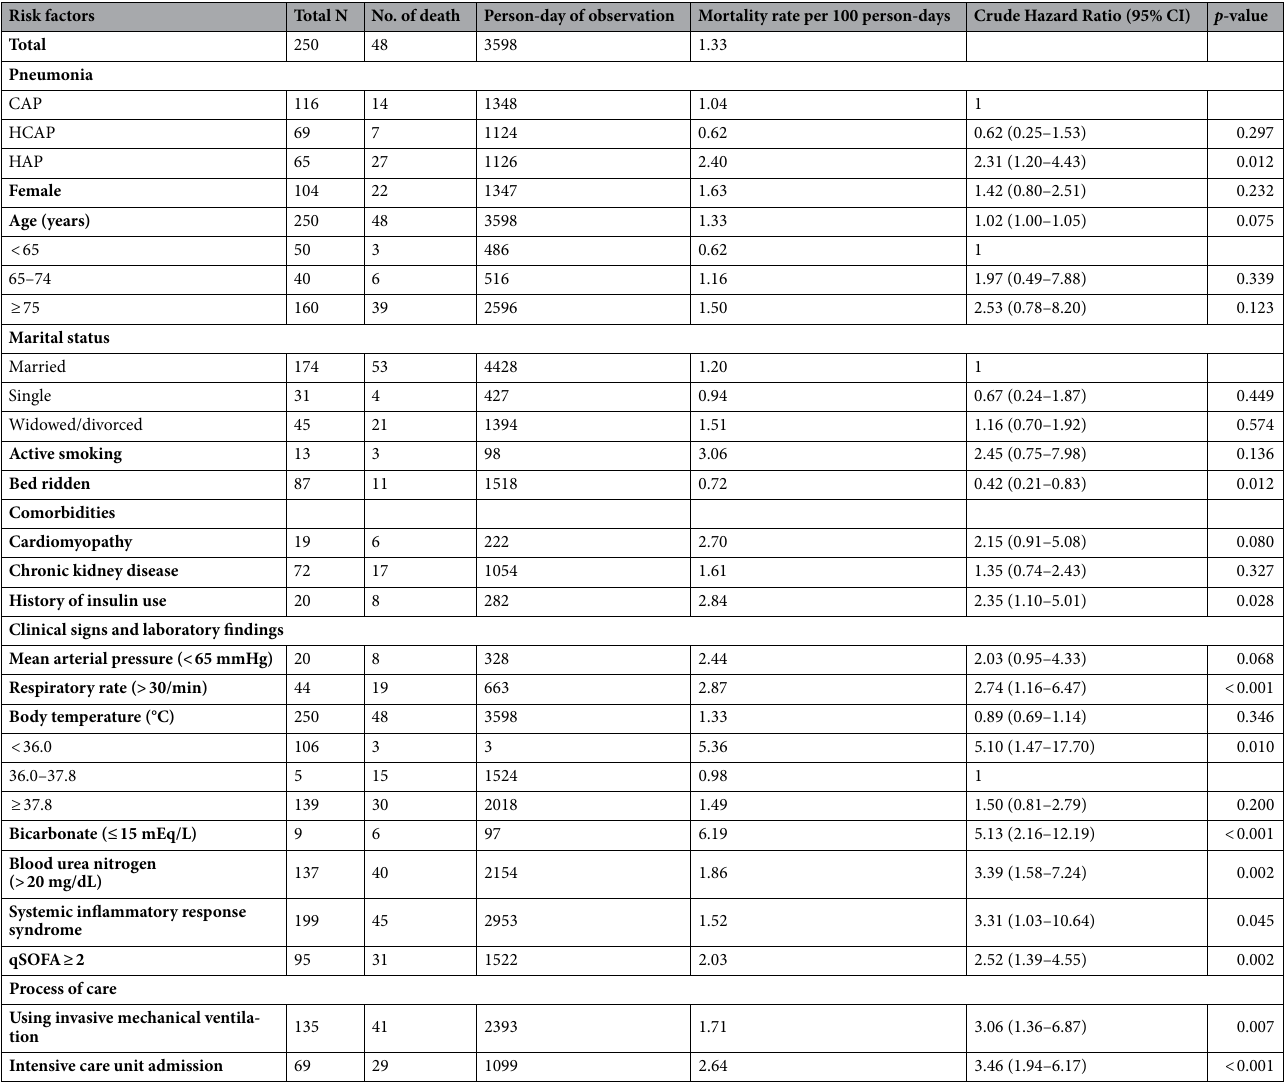
Table 4. Univariable cox regression analysis for risk factors of 28-day mortality. CAP: community-acquired pneumonia, HCAP; healthcare-associated pneumonia, HAP; hospital-acquired pneumonia, qSOFA; quick sequential organ failure